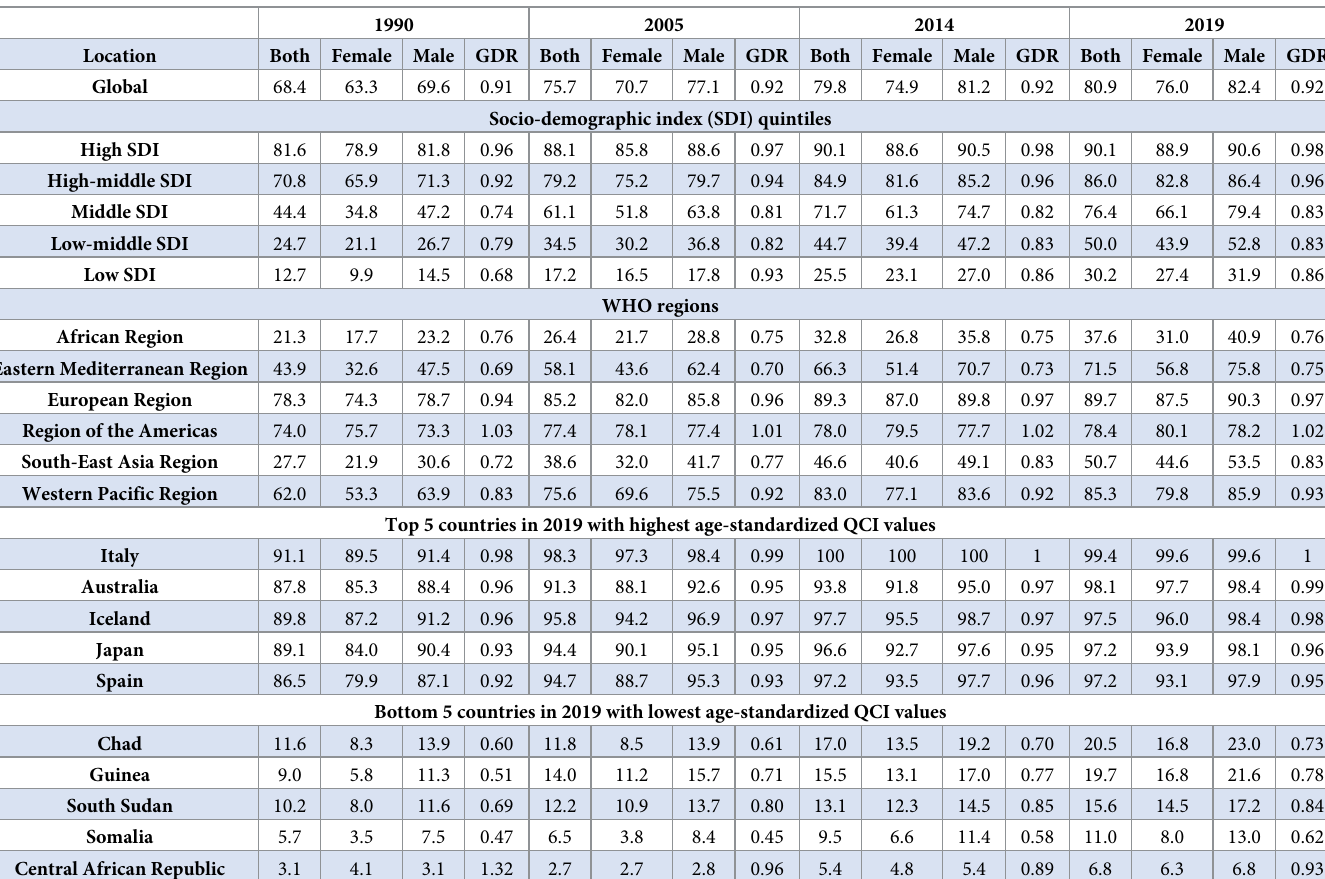
Table 2. Age-standardized QCI values (%) and GDR of the selected locations in 1990, 2005, 2014, and